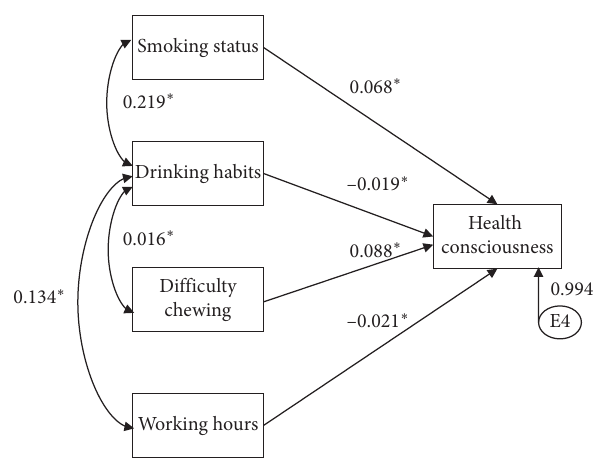
Figure 1: Path model of relationships between